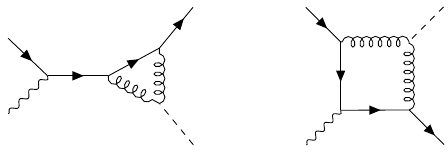
Figure 1: Sample diagrams at the leading order in HEFT. The external curly and dotted lines respectively denote the Z and H